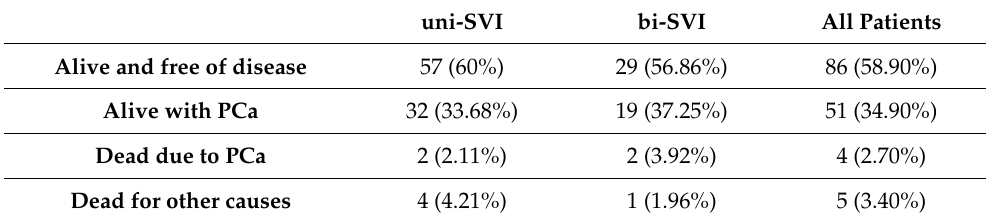
Table 2. Statuses of patients at the end of the